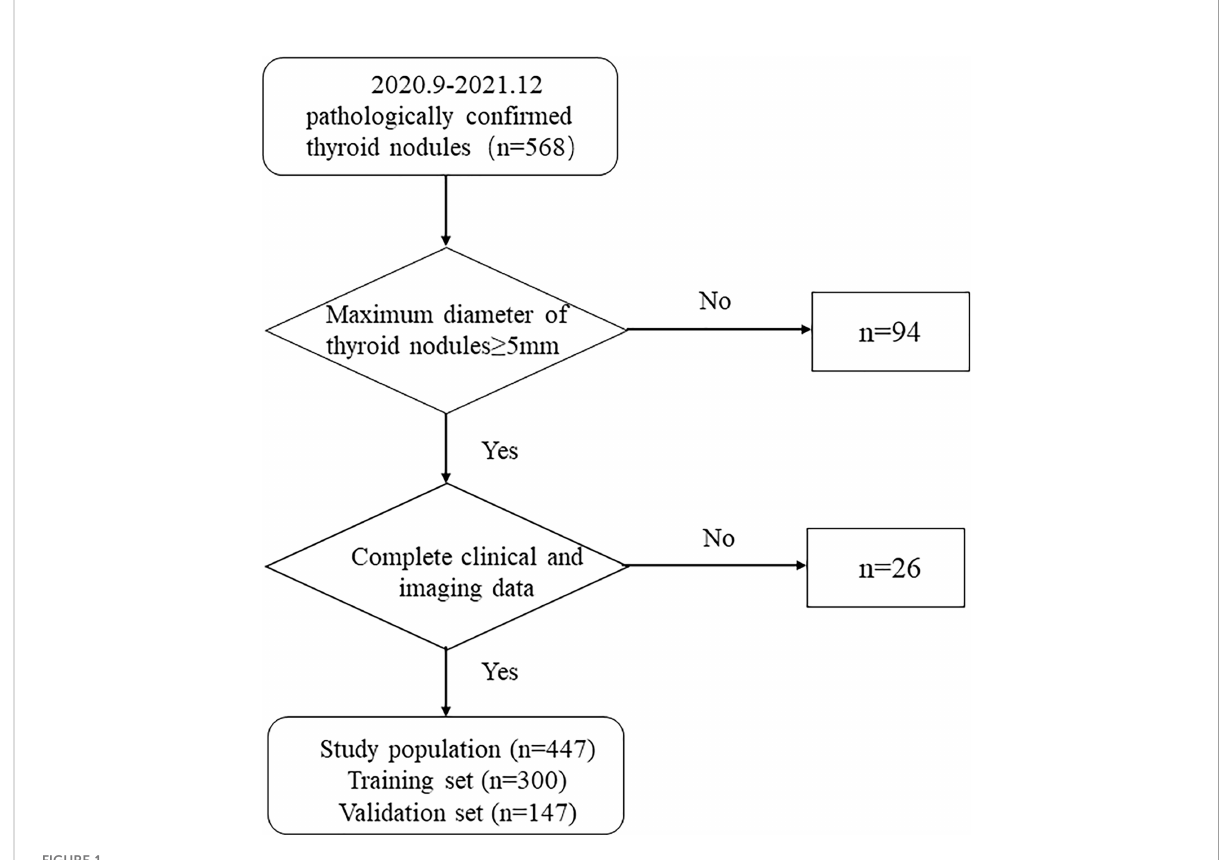
FIGURE 1 Flowchart of patient